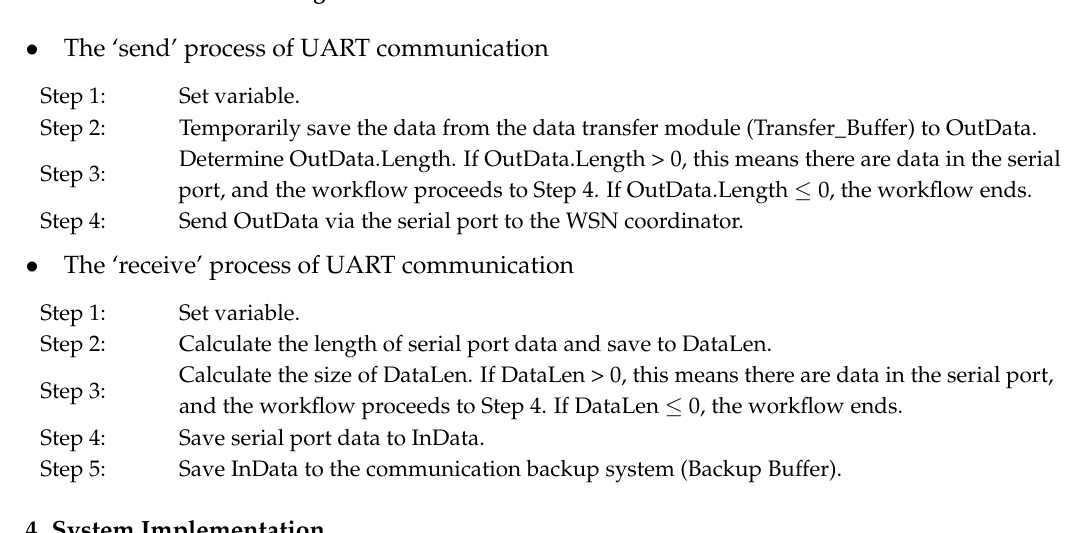
Figure 9. The ‘receive’ function of UART communication.